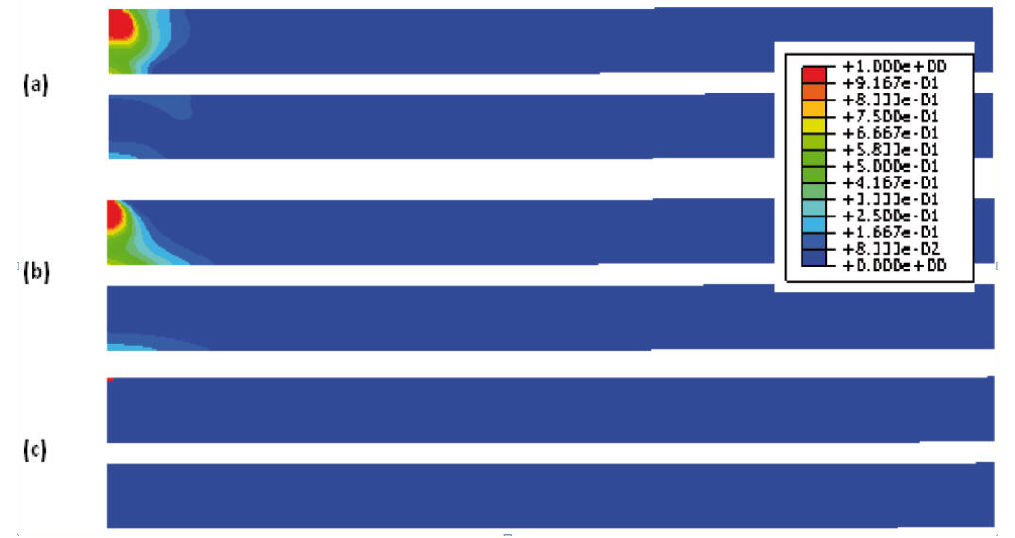
Figure 4. Contour plots of damage in laminated glass at 8.4 μ s after impact for small missile impact: ( a ) web-shaped damage D damage D . 12